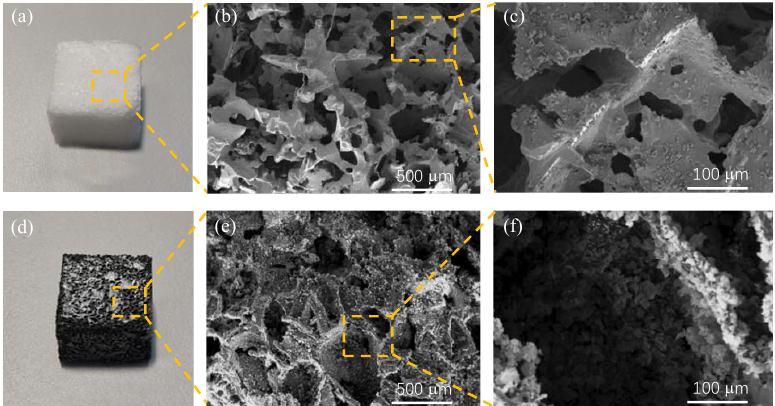
Figure 4. SEM micrographs of the porous graphene-sensitive unit and the porous PDMS frame ( a ) The porous PDMS sponge frame; ( b ) SEM micrograph of the porous PDMS sponge frame; ( c ) Magnified SEM micrograph of the porous PDMS frame; ( d ) The porous graphene-sensitive unit; ( e ) SEM micrograph of the porous graphene-sensitive unit; ( f ) Magnified SEM micrograph of the porous graphene-sensitive unit.